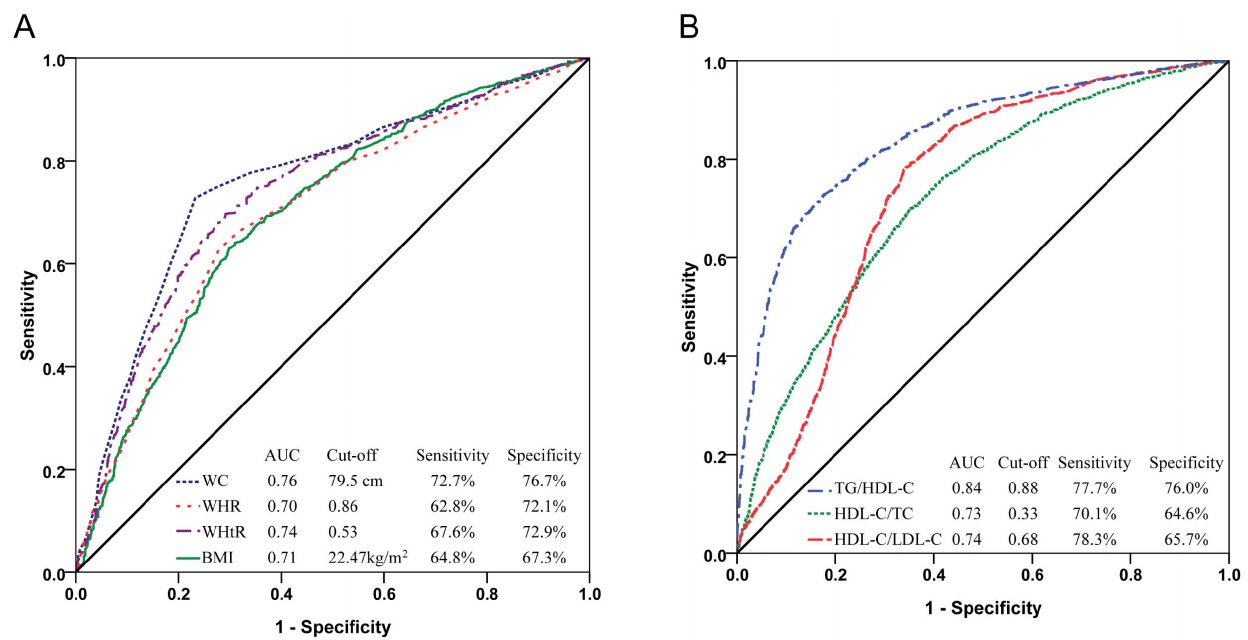
Figure 2. The ROC (receiver operating characteristic) curves for obesity (A) and atherogenic (B) indices to predict the presence of metabolic syndrome (MetS), as defined by the 2009 JIS criteria, among postmenopausal women in rural Canton.